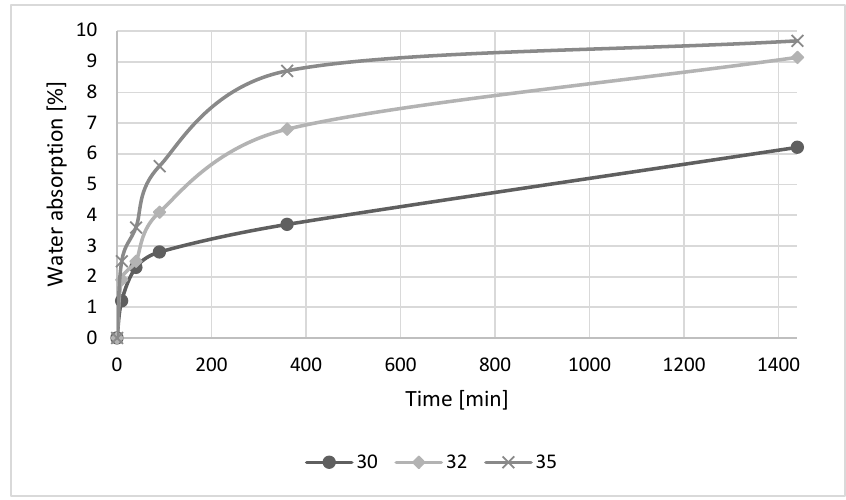
Figure 8. Water absorption results with different HDFS/water ratios in the mixture. An increase in the amount of water in the geopolymer mixture has a negative effect on the development of the strength of the geopolymer samples. With a constant amount of Na 2 O in the mixture, the molarity of the sodium hydroxide used decreases, and the mechanical strength of the geopolymer samples decreases. Another factor contributing to the weakening of geopolymer samples is porosity, which is caused by a greater number of water ‐ filled pores in a product with higher initial water content. The logical conse ‐ quence of increasing the porosity of the synthesized geopolymers is their reduced strength. The geopolymer sample with the least amount of water in the alkaline activator solution (w = 30%) had the greatest mechanical strength. Its flexural strength was 11.0